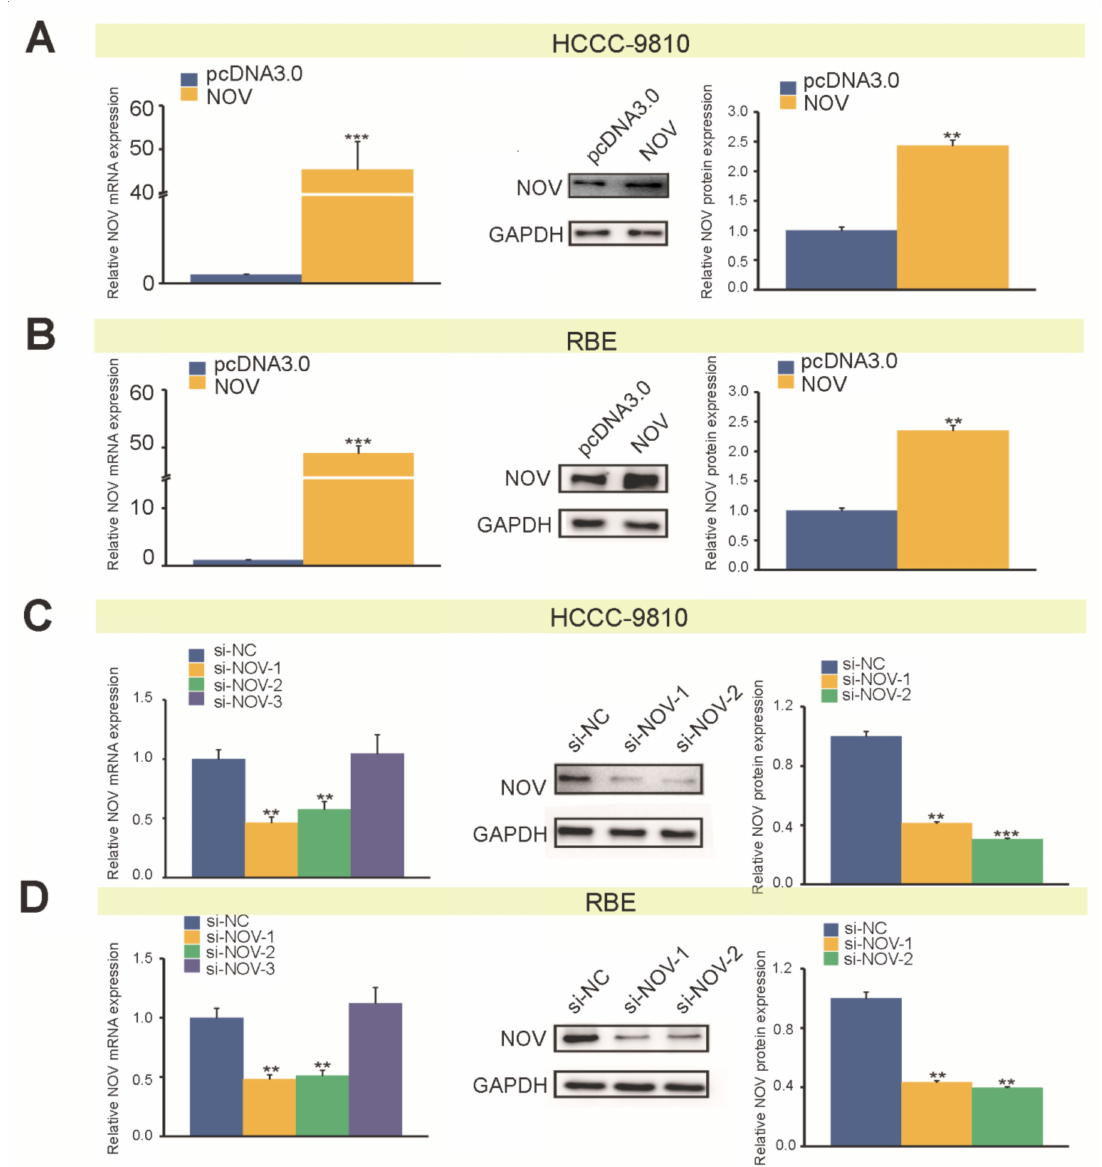
Figure 3. Overexpression and silencing of NOV in HCCC-9810 and RBE. ( A ). Expression efficiency of NOV mRNA (left) and protein (right) in HCCC-9810. ( B ) Expression efficiency of NOV mRNA (left) and protein (right) in RBE. ( C ) Gene silencing of NOV mRNA (left) and protein (right) in HCCC-9810. ( D ). Gene silencing of NOV mRNA (left) and protein (right) in RBE. All experiments are repeated three times independently, and the data are analyzed by t -test, ** indicates p < 0.01, *** indicates p <